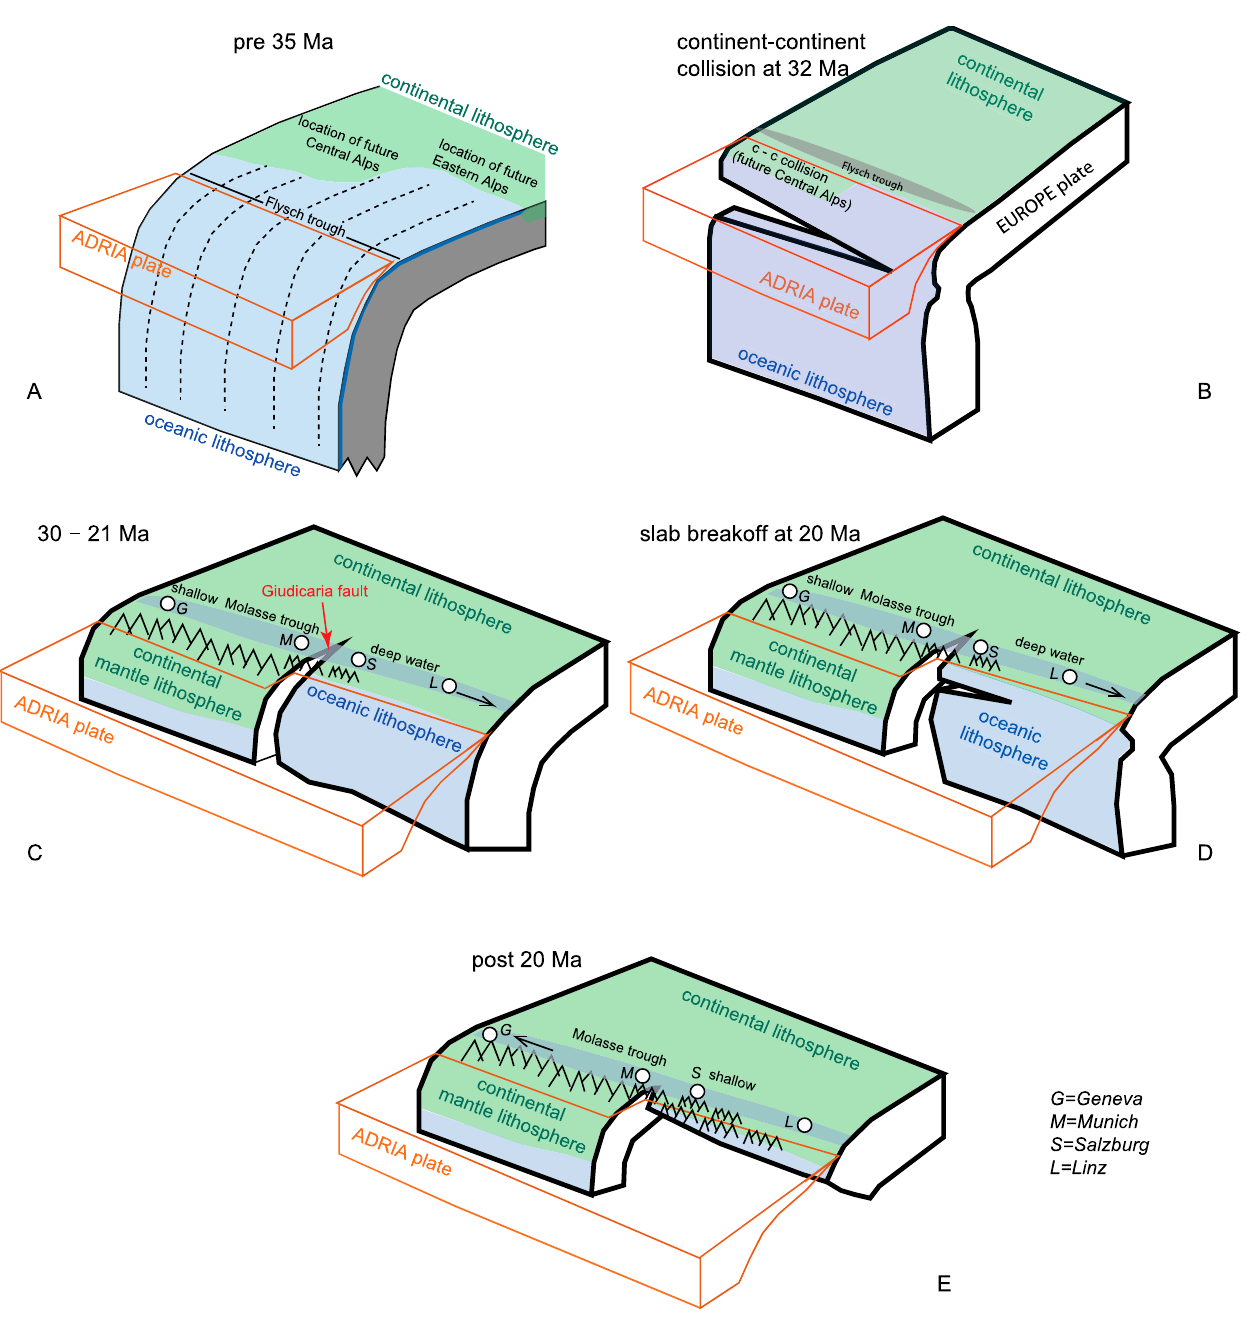
Figure 11. Sketch figure, showing the development of the collisional processes and the basin response. ( A ) Situation before 35 Ma, when the European oceanic plate was subducting beneath the Adriatic plate and when a flysch trough was established. ( B ) At c. 32 Ma, continent-continent collision started beneath the Central Alps. This resulted in necking and the removal of the subducted oceanic plate. ( C ) Slab breakoff beneath the Central Alps was associated with a rebound of the foreland plate and the growth of the Central Alpine topography. As a result, the erosional mass flux increased in the Central Alps, and the Molasse basin transitioned from the underfilled Flysch to the overfilled Molasse stage. Beneath the Eastern Alps, parts of the subducted oceanic plate remained attached to the continental plate, which resulted in a continued downwarping of the foreland plate. Therefore, the topography of the Eastern Alps was subdued, and the foreland basin remained in the Flysch stage. ( D ) Incipient slab delamination beneath the Eastern Alps resulted in a rebound of the